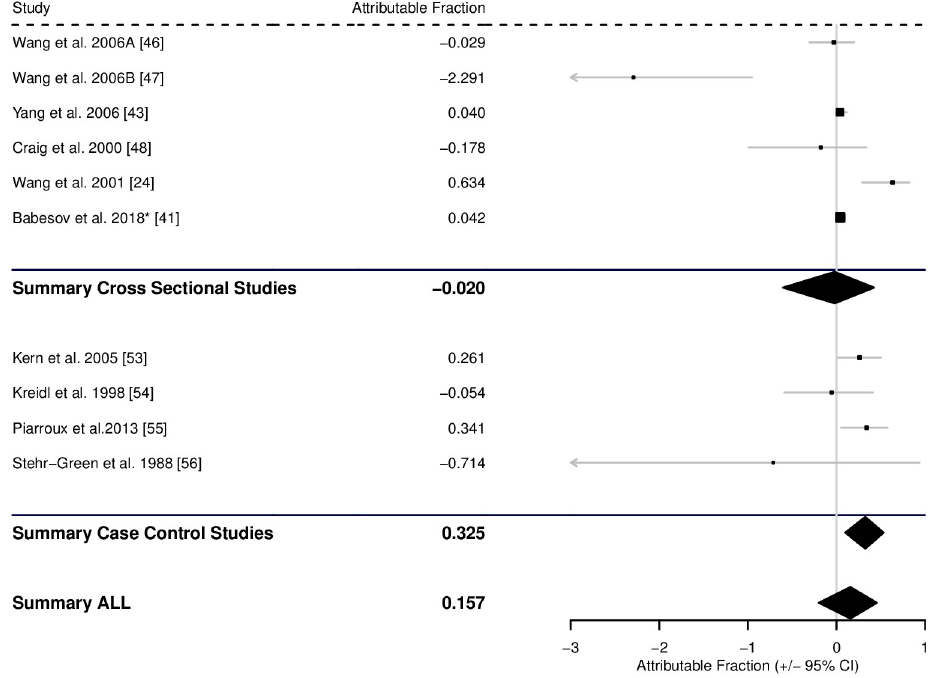
Fig 9. Forest plot for the attributable fraction for 6 cross-sectional studies and 4 case-control studies that analysed contaminated food as a potential risk factor for human AE. � Data not reported in study, but supplied by the